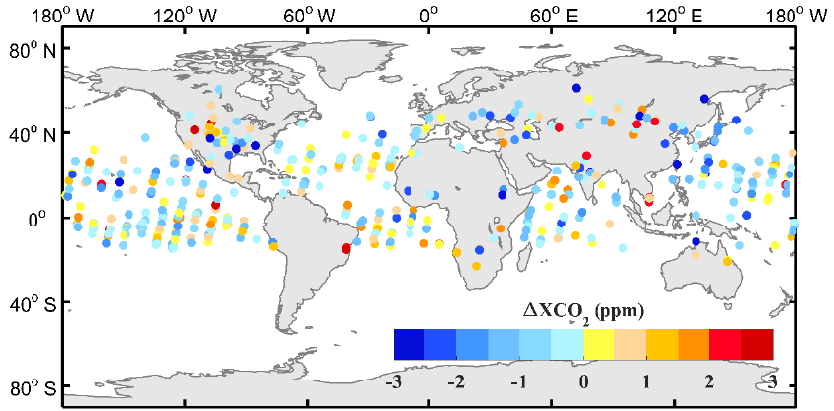
Figure 10. The spatial variation in the differences between GOSAT and OCO-2.